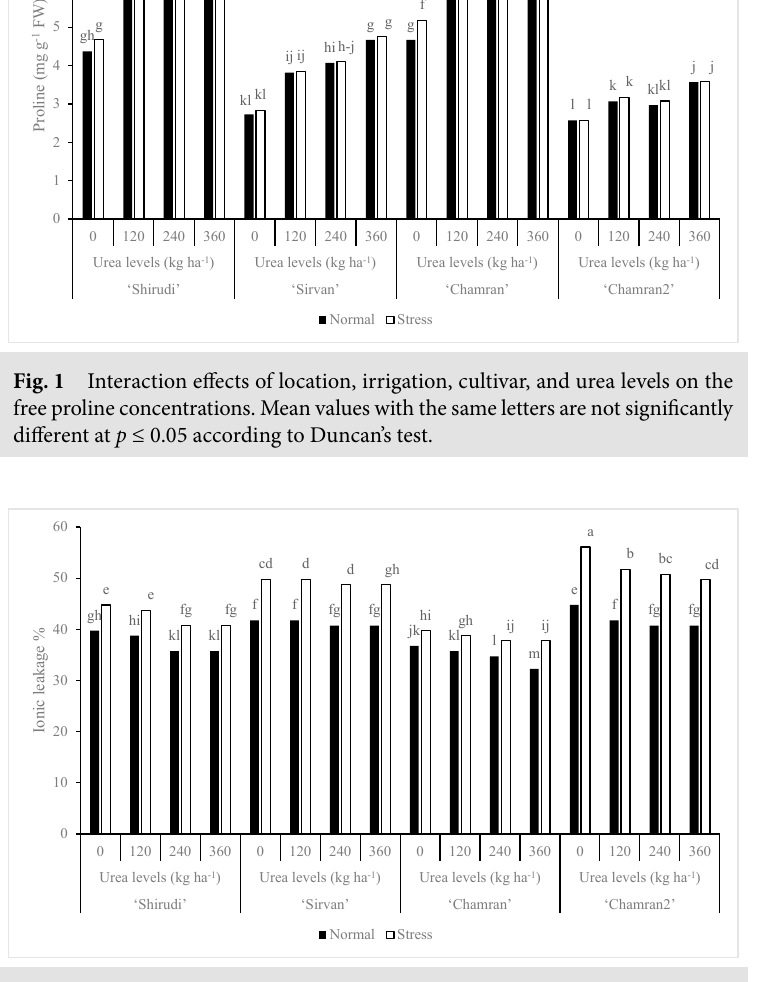
Fig. 2 Interaction effects of location, irrigation, cultivar, and urea levels on ionic leakage from leaves. Mean values with the same letters are not significantly different at p ≤ 0.05 according to Duncan’s test.